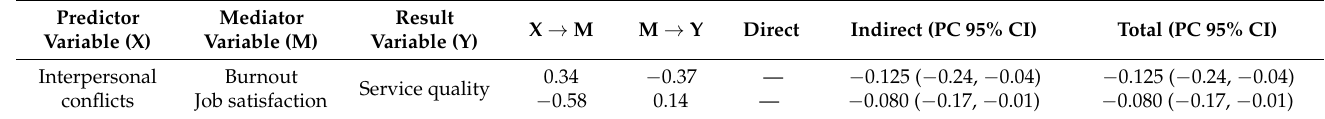
Table 2. Indirect and total effects of burnout and job satisfaction on service quality at the work-unit levels ( n = 91). Predictor Mediator Variable (X) Variable (M) Interpersonal Burnout conflicts Job